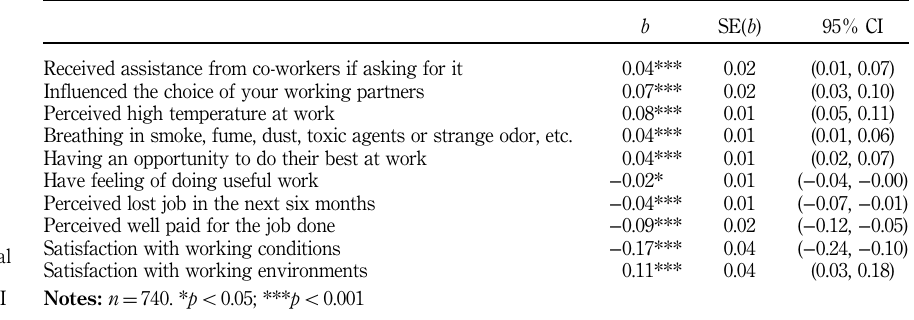
Table III. Work-environmental determinants correlated with